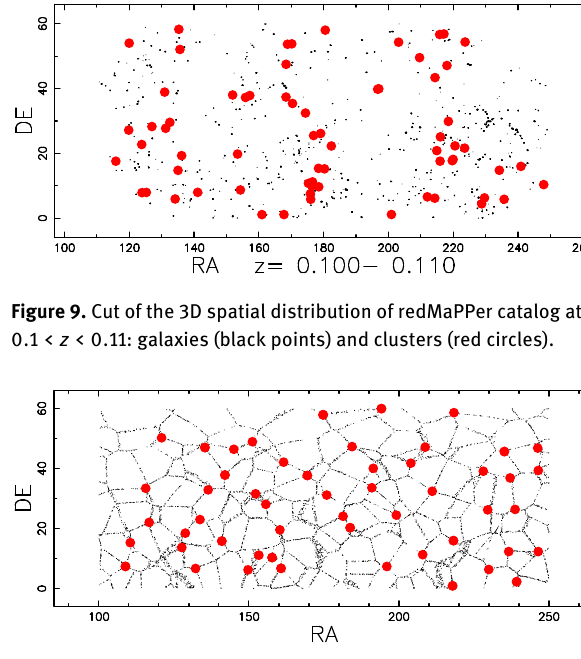
Figure 10. V P , s (2, 3) (black points) and spherical nodes (red circles) at 0.1 < z < 0.11 or 480 Mpc < D L 484 < Mpc . The numbers of galaxies and clusters are the same as in Figure